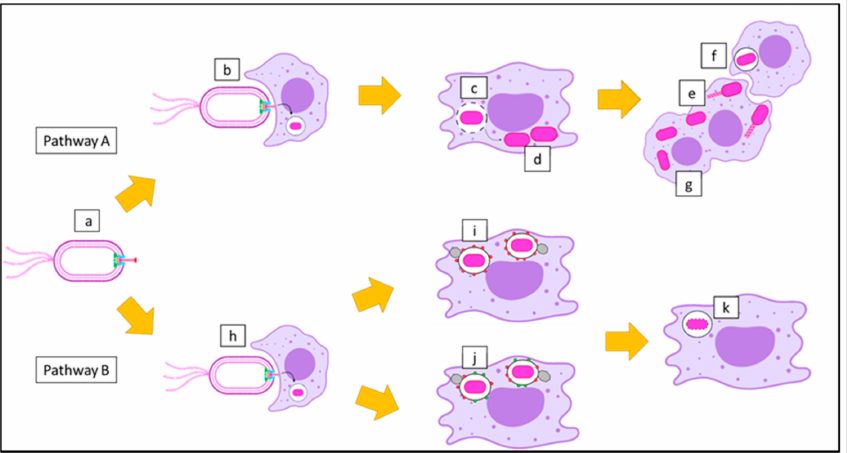
Figure 4. Postulation of the intracellular survival of B. pseudomallei . ( a ) A motile Gram-negative B. pseudomallei with Burkholderia secretion apparatus (Bsa) can use two pathways after infection of host cells. ( b ) Invasion of B. pseudomallei into a macrophage, where they are internalized into the phagosome. ( c ) B. pseudomallei escapes from the phagosome by rupturing the phagosome membrane, and ( d ) replicates in the cytoplasm of the macrophage. ( e ) B. pseudomallei forms actin tails, which